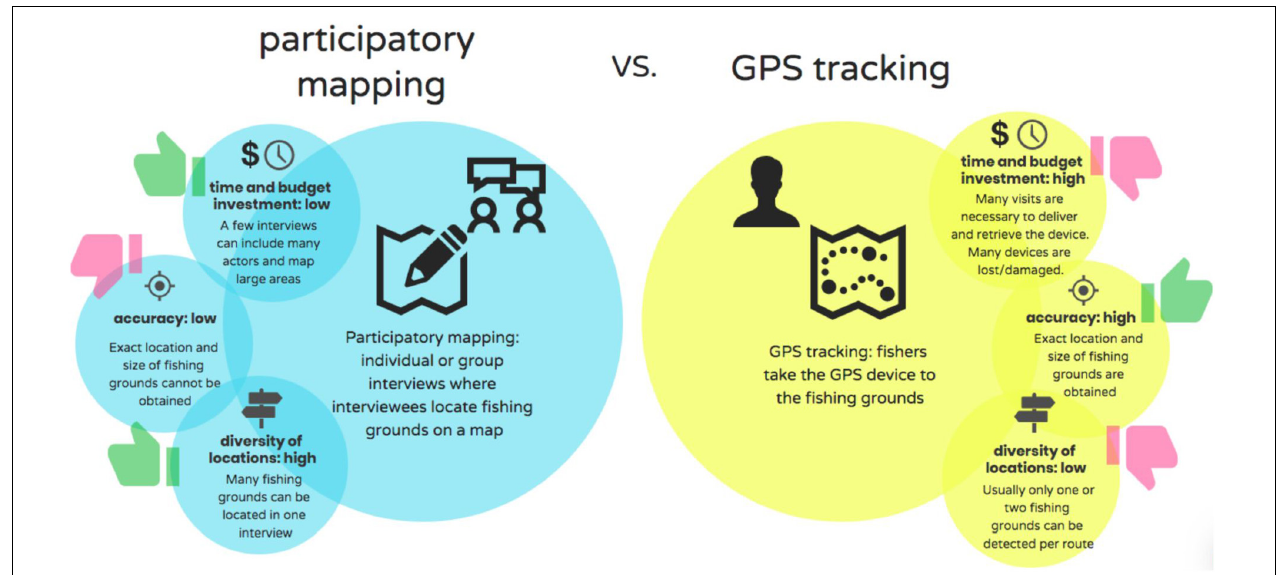
FIGURE 2 | Comparison between participatory mapping and GPS